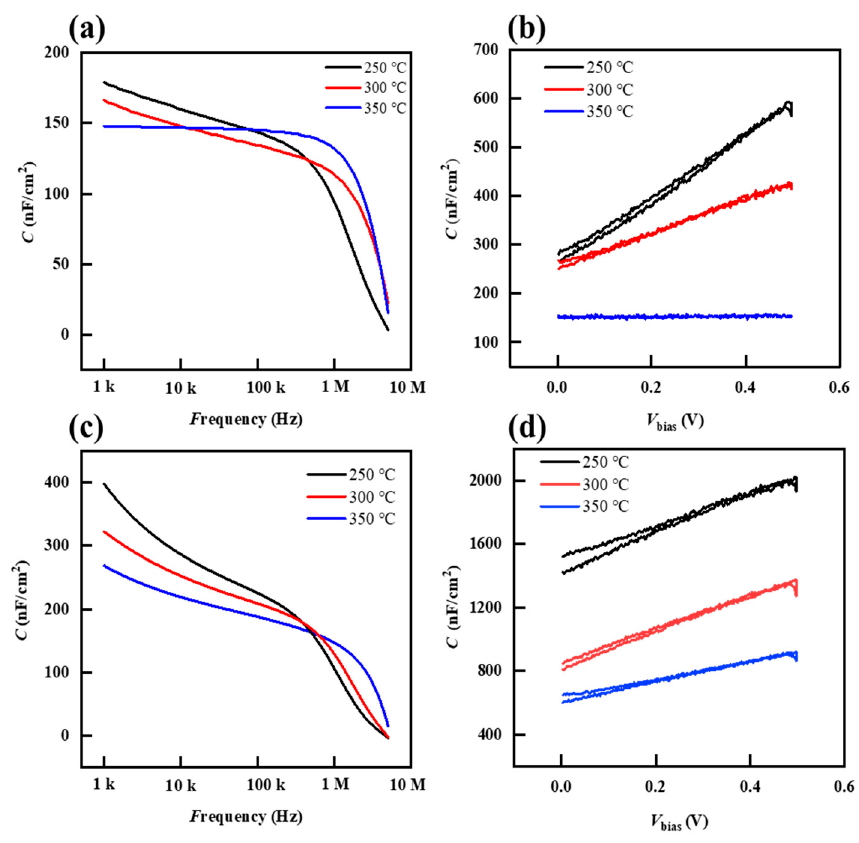
Figure 3. ( a ) Capacitance-frequency curves and ( b ) quasistatic capacitance-voltage curves of the AlO x dielectrics without water treatment; ( c ) Capacitance-frequency curves; and ( d ) quasistatic capacitance-voltage curves of the AlO x dielectrics with water treatment.